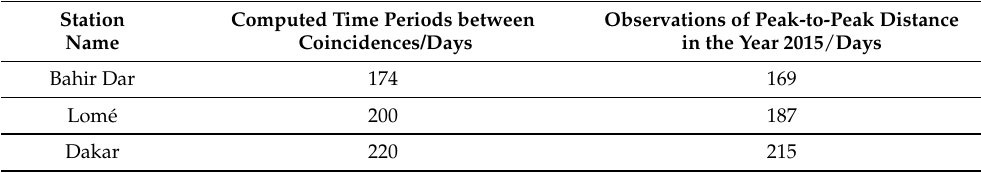
Table 2. Comparison of coincidences between the sunset terminator and geomagnetic declination by the observed scintillation of peak-to-peak